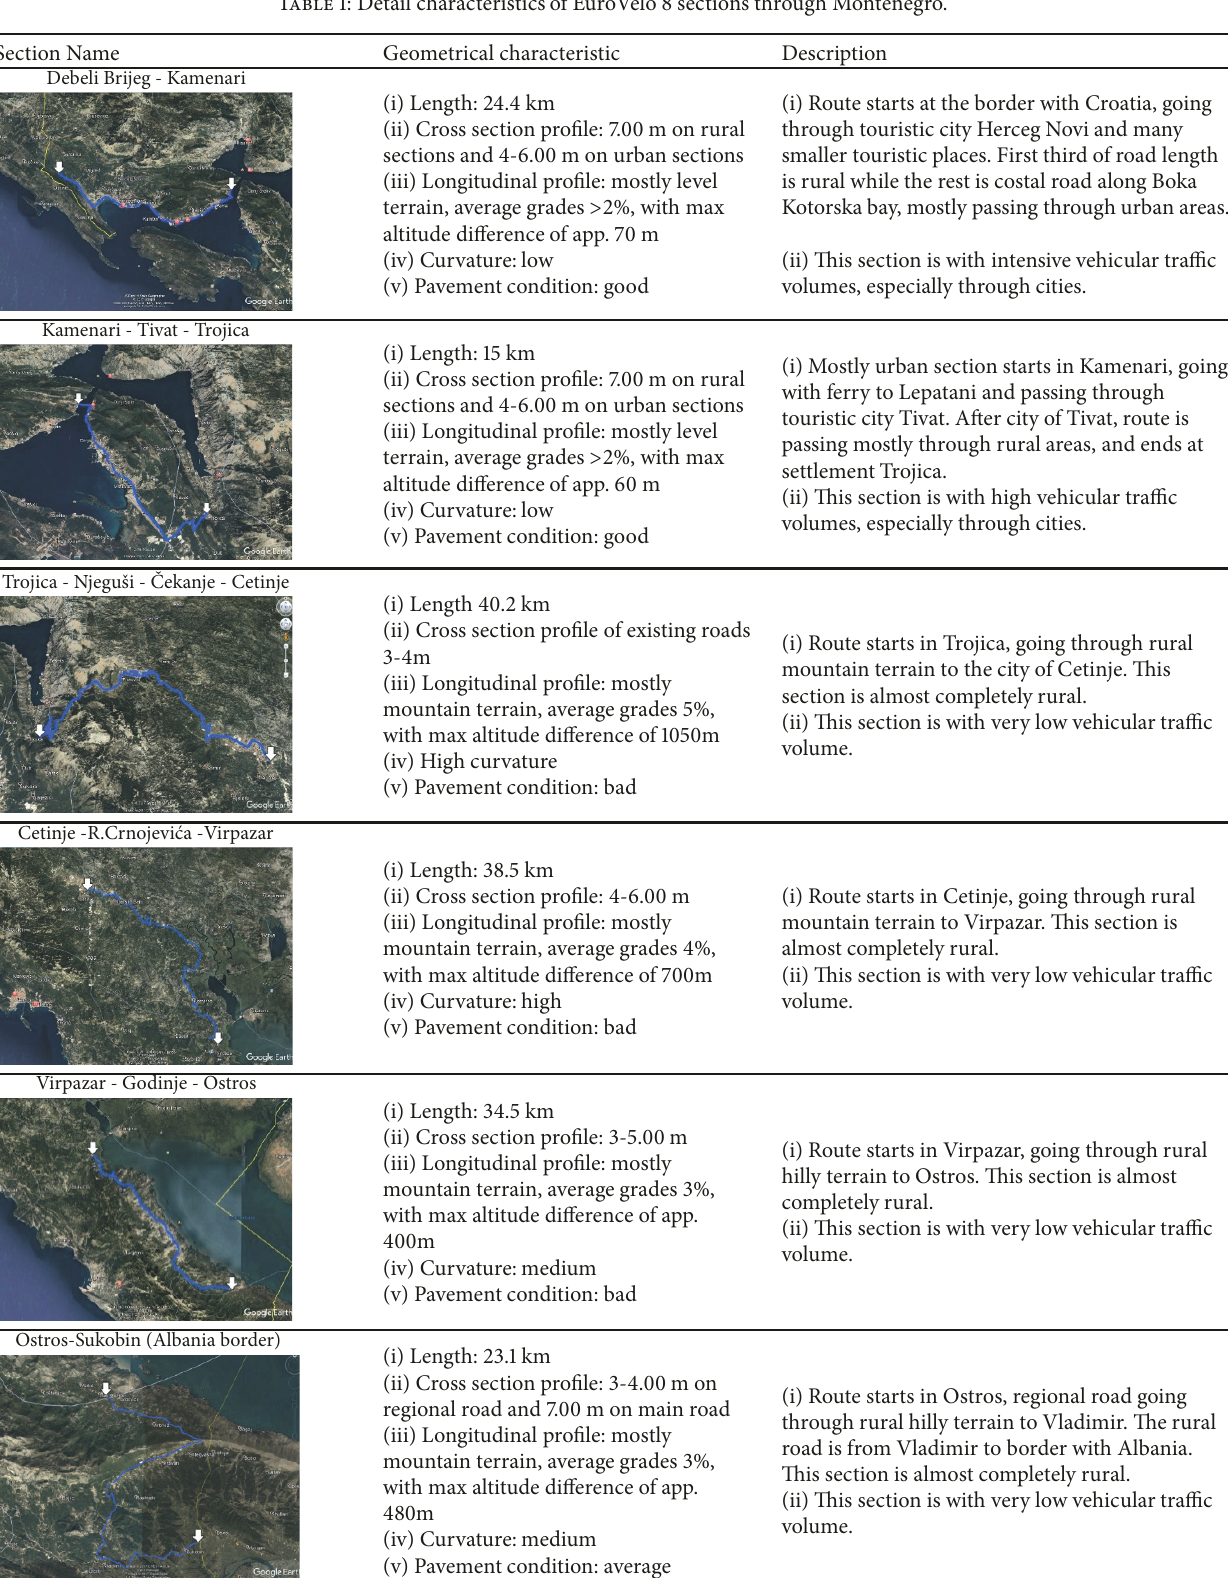
Table 1: Detail characteristics of EuroVelo 8 sections through